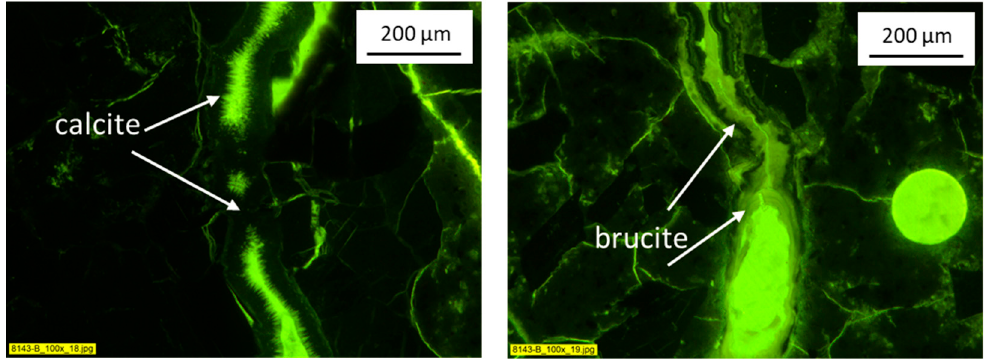
Figure 10. Crack in core PC-4SF, Left: Massive precipitation of calcite along the crack face with small bridges closing the crack, Right: Brucite interlayered with dense calcite. The porous brucite is fully impregnated with epoxy. Fluorescent light mode.